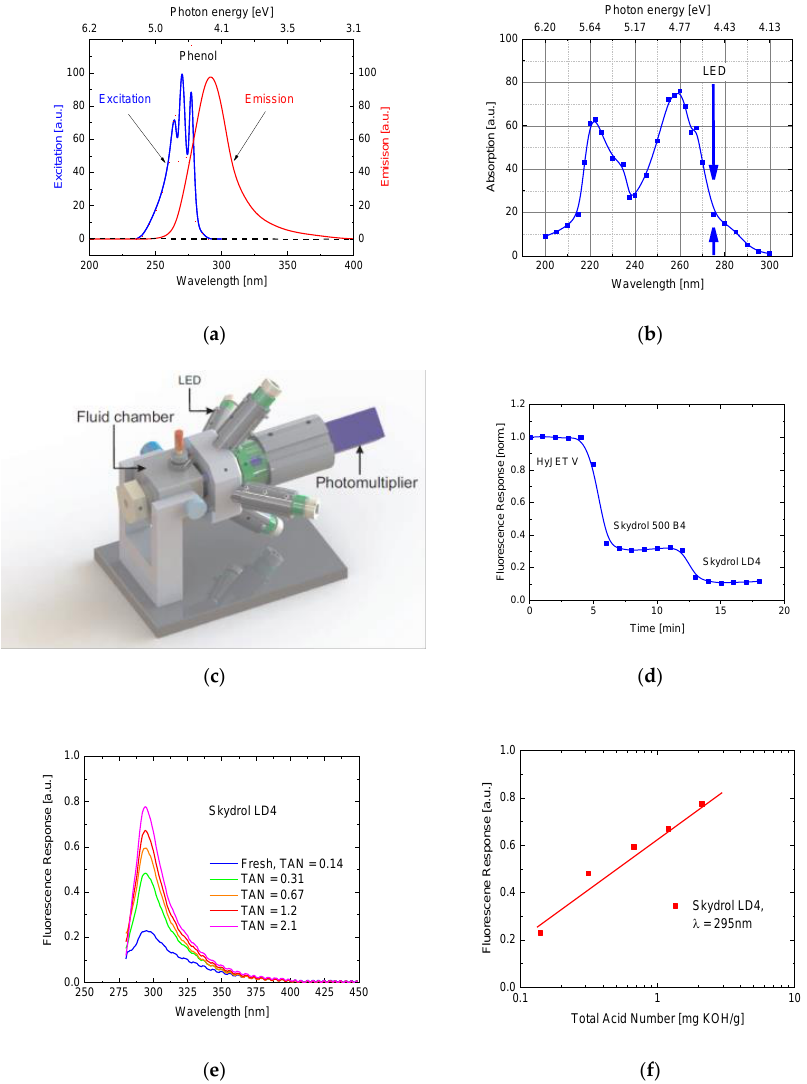
Figure 10. ( a ) Photo excitation and emission spectra of free phenol molecules [24]. ( b ) Optical absorption spectrum of Skydrol LD4 [6]. Arrows indicate the peak emission of the UV LEDs that were used in the fluorescence setup of Figure 9c. ( c ) Test setup for fluorescence measurements on aviation hydraulic fluids featuring four UV LEDs emitting at 𝜆 ≈ 275 nm and a photo-multiplier tube [6]. ( d ) Fluorescence response of undegraded aviation hydraulic fluids with different aromatic contents [6]. ( e ) Fluorescence spectra of Skydrol LD4 degraded up to increasingly larger TAN values [6]. ( f )